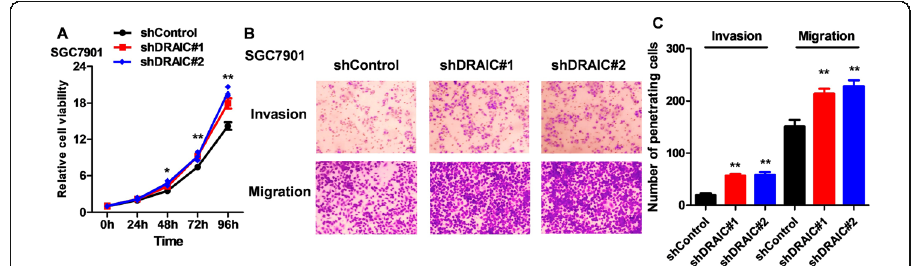
Fig. 6 Biological effects of shDRAIC on GC cells. a. The effects of shDRAIC on SGC-7901 cell proliferation. b. The effects of shDRAIC on SGC-7901 cell metastasis. c. Quantitative results of ImageJ analysis Fig. 6b. Quantitative data are presented as means ± SD. * P < 0.05, ** P < 0.01 compared with the shControl